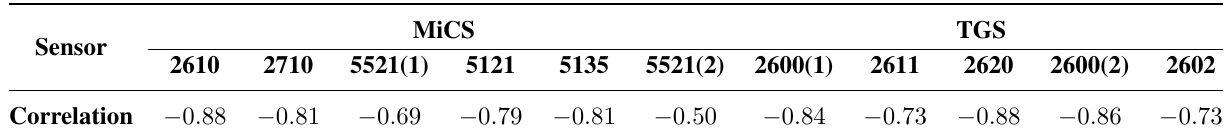
Table 3. Pearson correlation coefficient between the Euclidean distance δ of the trade-off curve to the origin and F-measure for each sensor. The strong correlation shows that the distance to the origin is a suitable heuristic to select the hyper-parameter λ